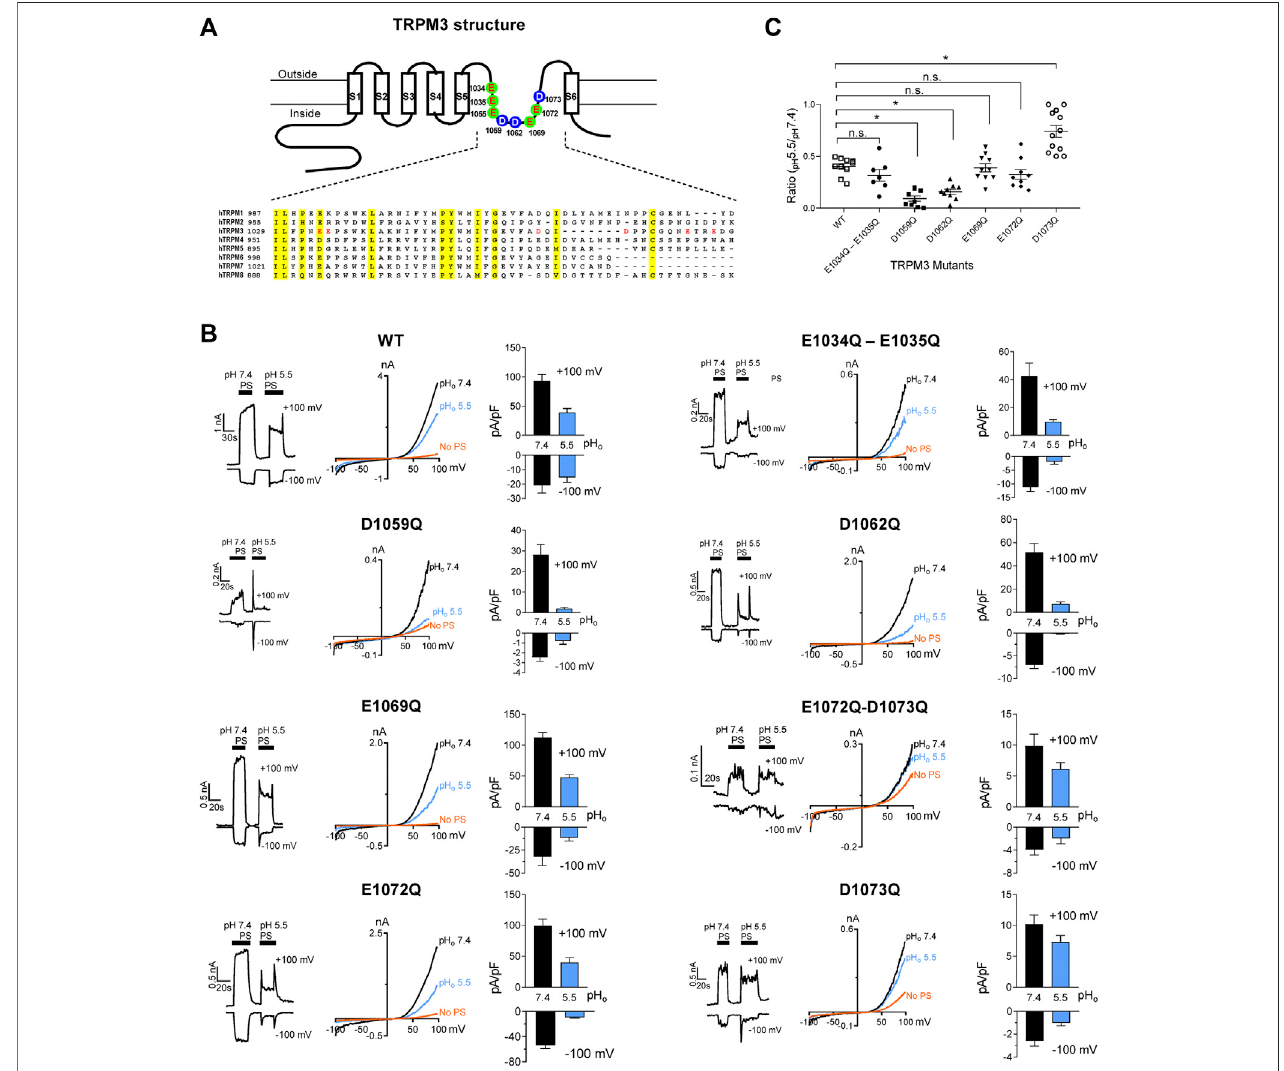
FIGURE 7 | Changes in protons sensitivity of TRPM3 mutants. (A) Upper panel: schematic of TRPM3 structure and the substituted amino acid residues in the putative pore region of hTRPM3. Lower panel: sequence alignment of human TRPM channel pore regions. (B) Time course and representative recordings of TRPM3 mutantsandwild-typecurrentselicitedbyvoltagerampsranging − 100to+100 mV,attheindicatedpH o .Bargraphsshowmeanoutwardandinwardcurrentamplitudes at the indicated pH o (mean ± SEM, n (cid:2) 7 – 12 cells) Internal solution had a constant pH of 7.20 for all the recordings. (C) The ratio of outward current amplitudes at pH o 5.5 and pH o 7.4, of TRPM3 mutants and WT control. To obtain these ratios, the current elicited by +100 mV at pH o 5.5 was divided by the current elicited by +100 mVatpH o 7.4ofthesamecell( n (cid:2) 7 – 12 cells). p values,comparingeachgroupwithWT-TRPM3,*indicates p < 0.05byunpairedStudent ’ st-test; “ n.s. ” indicates not statistically signi fi